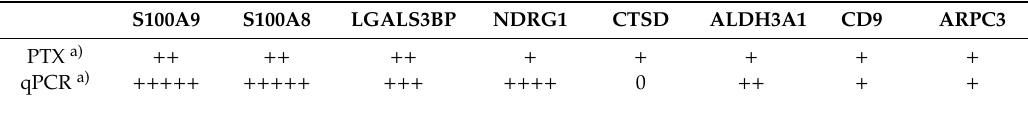
Table 3. Protein and mRNA abundance changes of selected target genes determined by quantitative PTX and